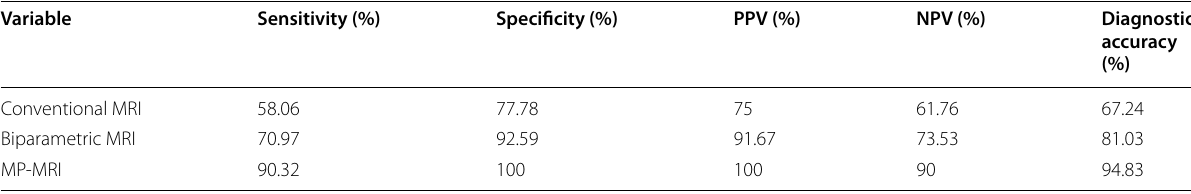
Table 6 Diagnostic performance sensitivity, specificity, PPV, NPV and diagnostic accuracy of Bosniak classification of 58 cystic lesions Variable